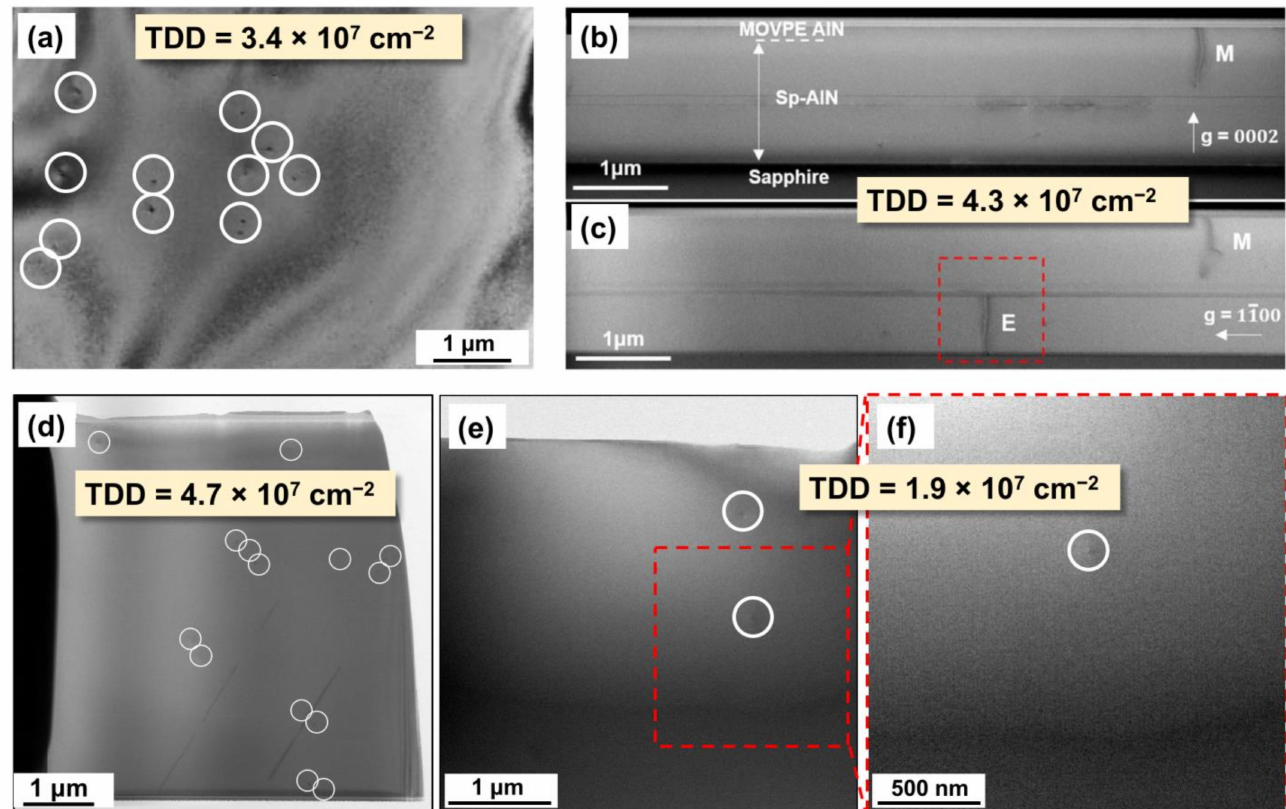
Figure 24. ( a ) Plan-view TEM image of ELOG-AlN grown by Meijo University. Reprinted from J. Cryst. Growth, 298, Masataka Imura et al., “Epitaxial lateral overgrowth of AlN on trench-patterned AlN layers”, 257–260, Copyright (2007), with permission from Elsevier. ( b , c ) Cross-sectional TEM images of HTA-AlN grown by Mie University. Reprinted from [74]. Copyright (2020) The Japan Society of Applied Physics. ( d ) Plan-view TEM image of 5.6 µ m-thick MSG-AlN grown by Guangdong Academy of Sciences (GDAS). Reprinted with permission from [17]. Copyright {2018} American Chemical Society. ( e , f ) Plan-view TEM images of 11 µ m-thick MSG-AlN grown by